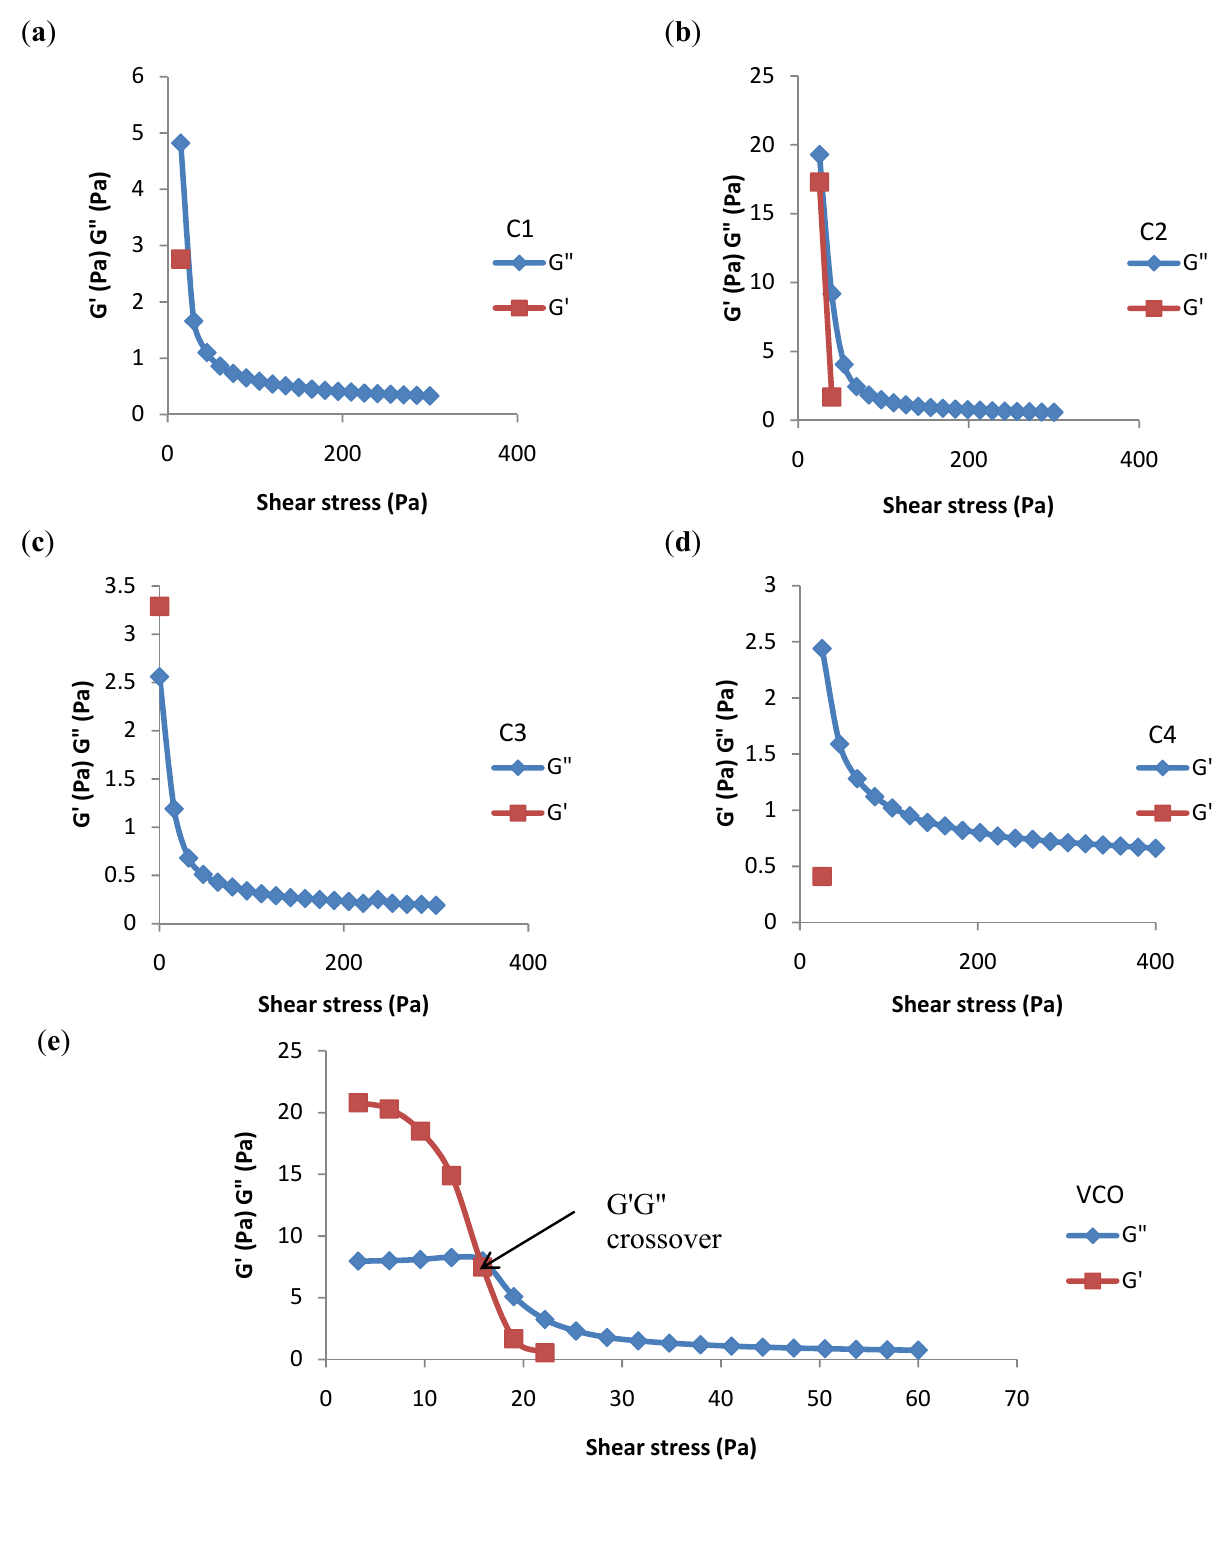
Figure 4. Storage modulus G' (Pa) and loss modulus G'' (Pa) vs. shear stress (Pa) data for ( a ) C1; ( b ) C2; ( c ) C3; ( d ) C4; ( e ) virgin coconut oil emulsion and ( f ) viscosity η (Pa.s) vs. shear stress (Pa) for commercial emulsion samples and virgin coconut oil